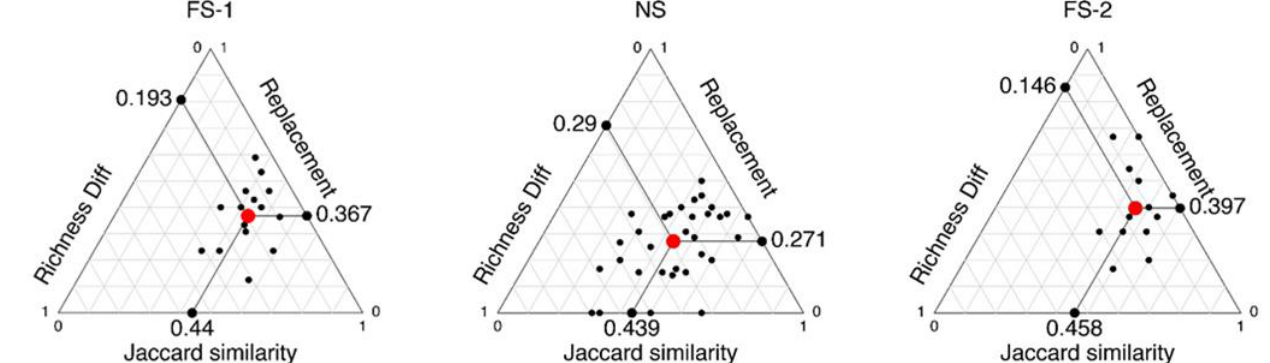
Figure 5. Simplex plots based on similarity, richness differences, and species replacement for all the pairwise comparisons of the subfossil Cladocera assemblage of the three sites of the oxbow lake. Three sites: fishing site-1 (FS-1), natural site (N.S.), fishing site-2 (FS-2).